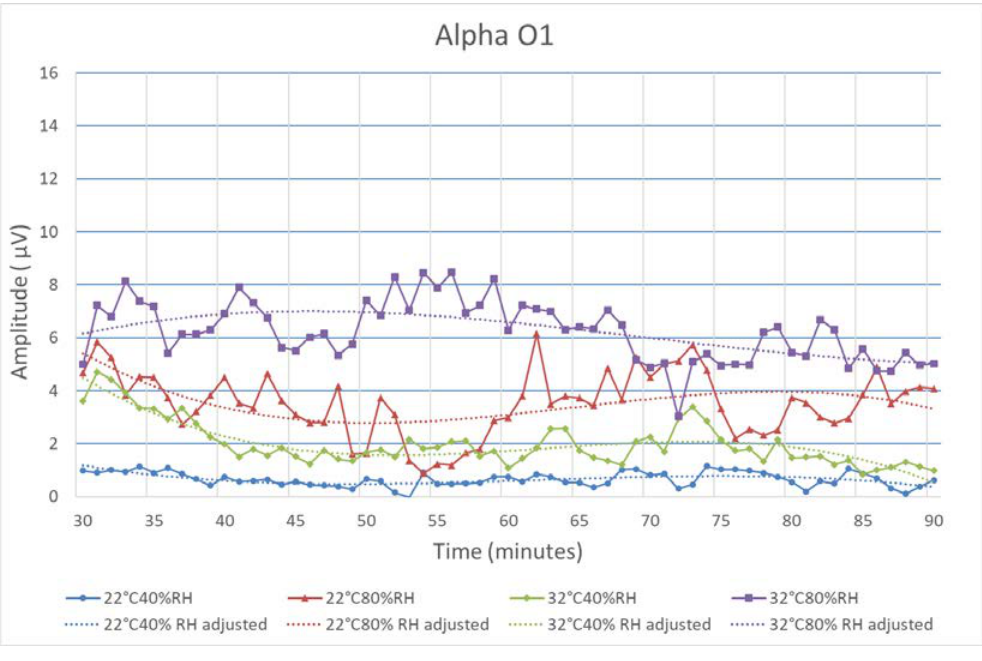
Figure 5. Mean values of Alpha O1 waves from the 15 volunteers at different temperatures